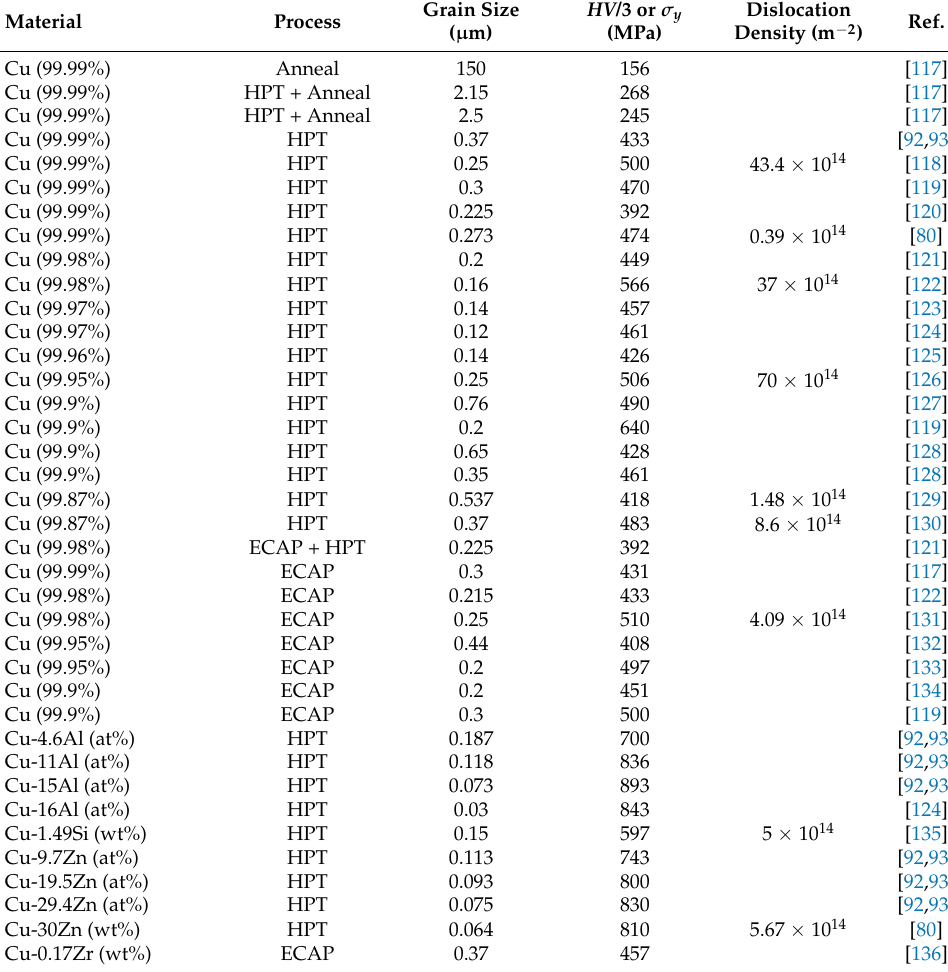
Table A3. Reported experimental data for grain size, yield strength or hardness divided by three, and dislocation density for copper and its alloys before and after processing by severe plastic